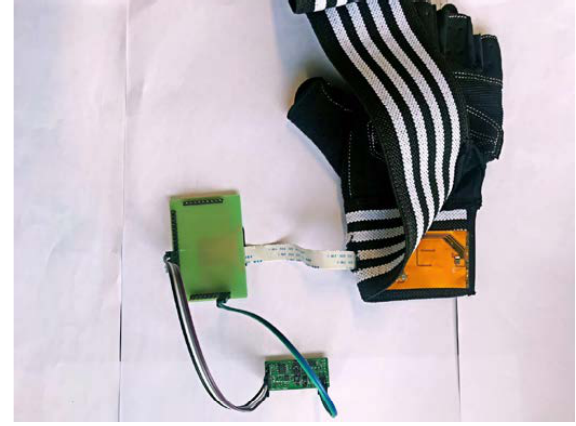
Figure 1. The panorama of the system.